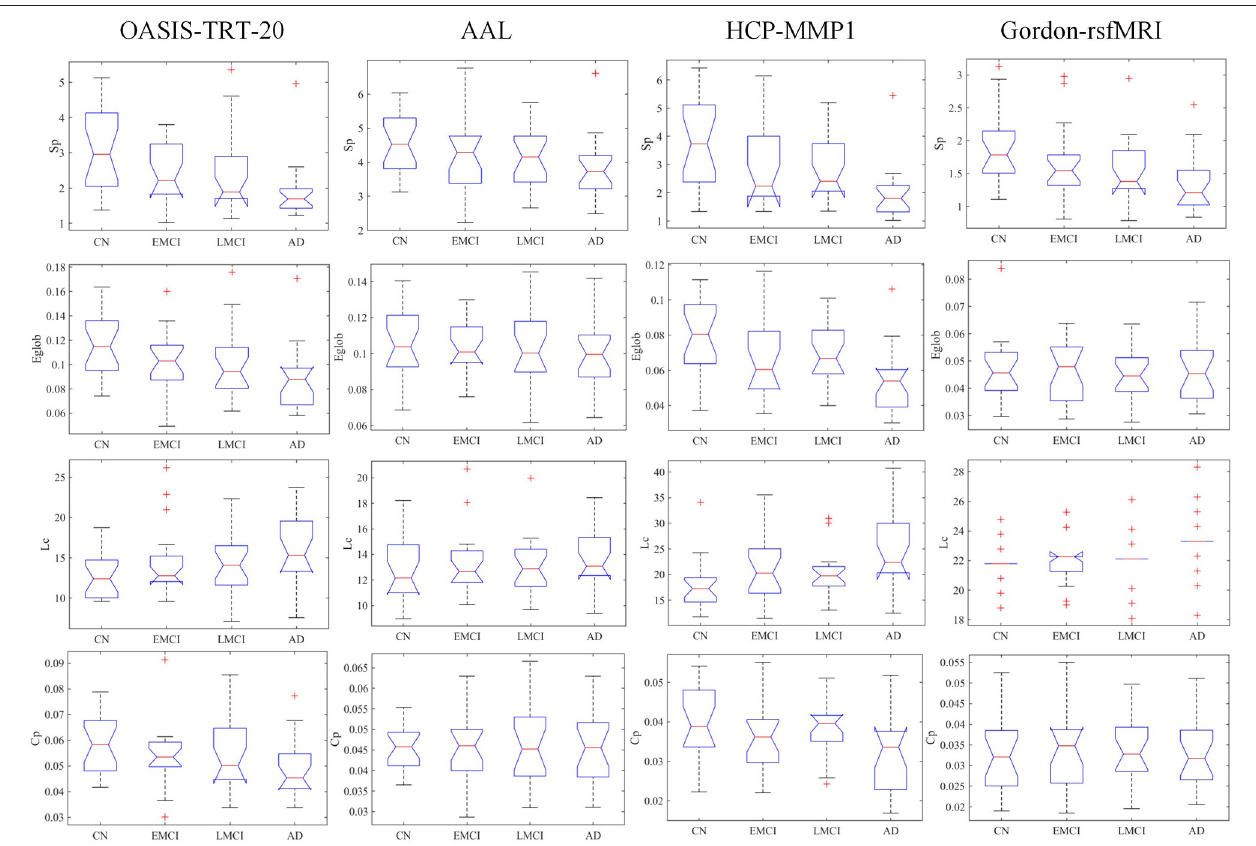
FIGURE 2 | Group median and interquartile ranges of the SC topological metrics for each group, including network strength S p , global efficiency E glob , characterized path length L c , and cluster coefficient C p . P -values derived from Kruskal-Wallis tests assessing SC topological differences among NC, EMCI, LMCI, and AD for each parcellation scheme are reported in Table 3